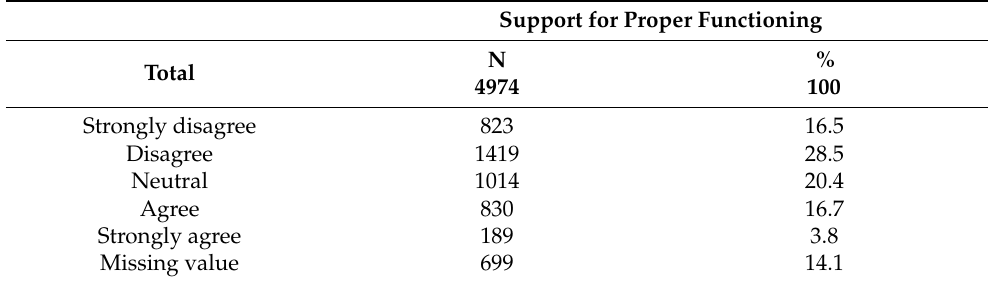
Table 2. Respondents’ opinion on government’s role on the functioning of practice during the COVID-19